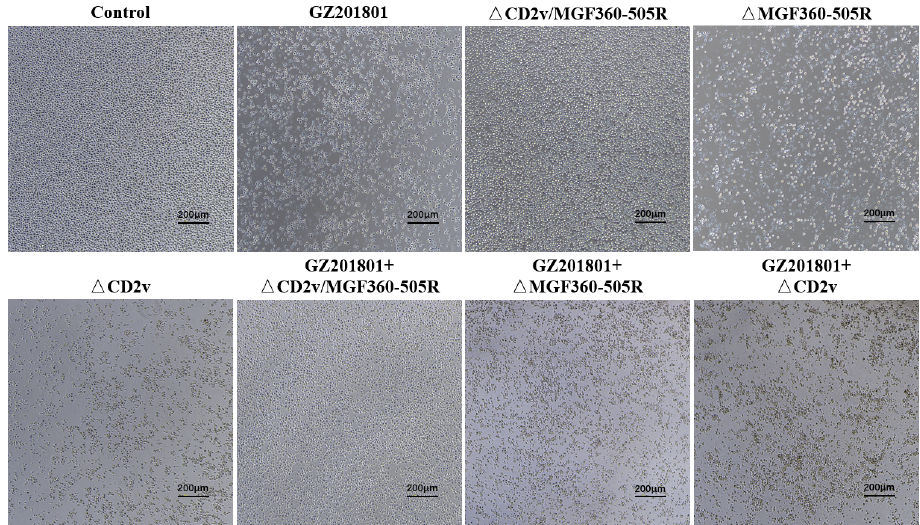
Figure 2. The CPE of infected primary PAMs with GZ201801-ASFV, ∆ CD2v/ ∆ MGF360-505R-ASFV, ∆ MGF360-505R-ASFV, and ∆ CD2v-ASFV. GZ201801-ASFV infection of PAMs produces more serious CPE. ∆ CD2v/ ∆ MGF360-505R-ASFV or co-infection with GZ201801-ASFV and GZ201801-ASFV produced less CPE in PAMs. PAMs were either infected with GZ201801-ASFV, ∆ CD2v/ ∆ MGF360- 505R-ASFV, ∆ MGF360-505R-ASFV, or ∆ CD2v-ASFV at a MOI of 0.1.